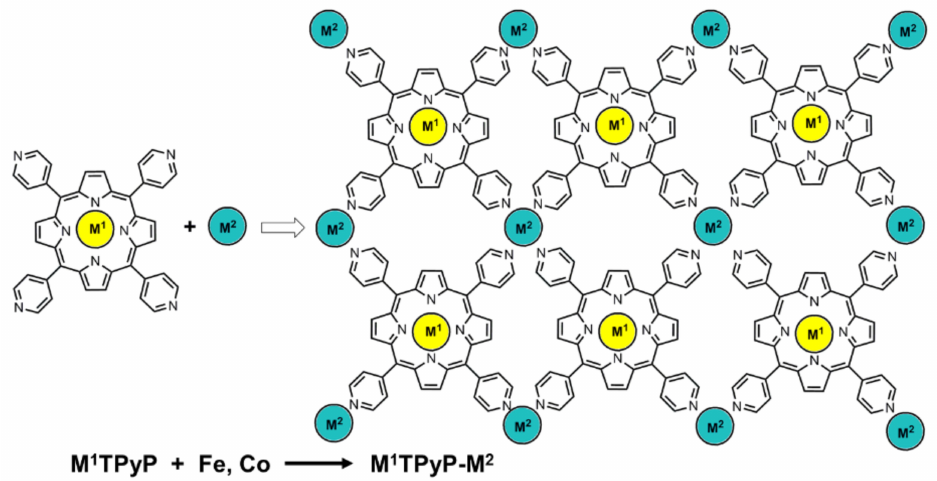
Figure 6. Synthesis and chemical structures of M 1 TPyP-M 2 . Reproduced from ref.